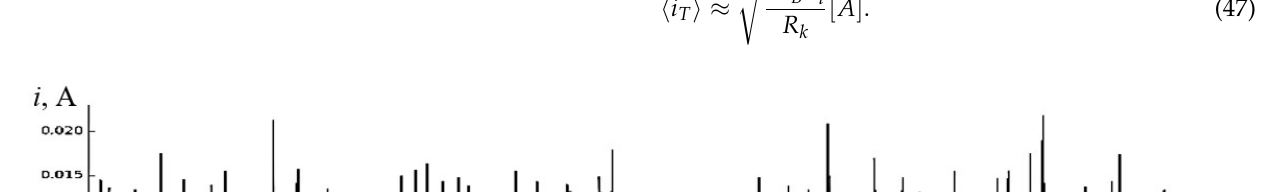
Figure 5. The semiconductor ring equivalent circuit.